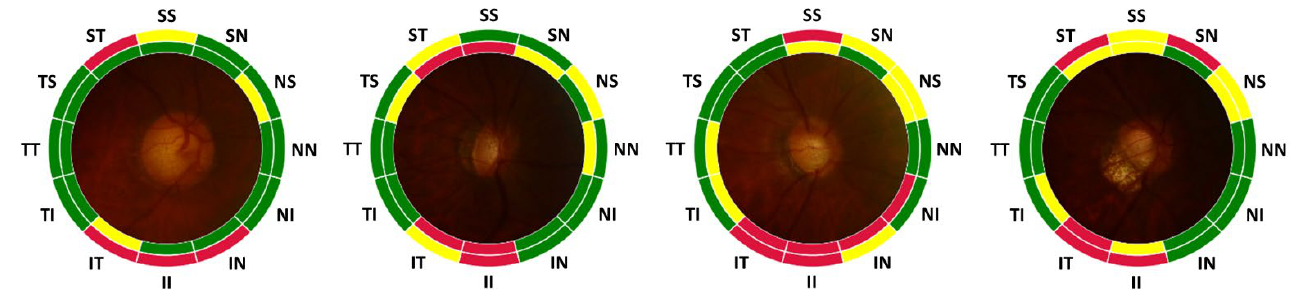
Figure 8. Examples of prediction failure. Model fails to estimate RNFL thickness accurately when the quality of fundus photograph is bad in terms of contrast, brightness, and blurriness and arrives at an incorrect thinning level prediction consequently. Data is based on rejected samples.